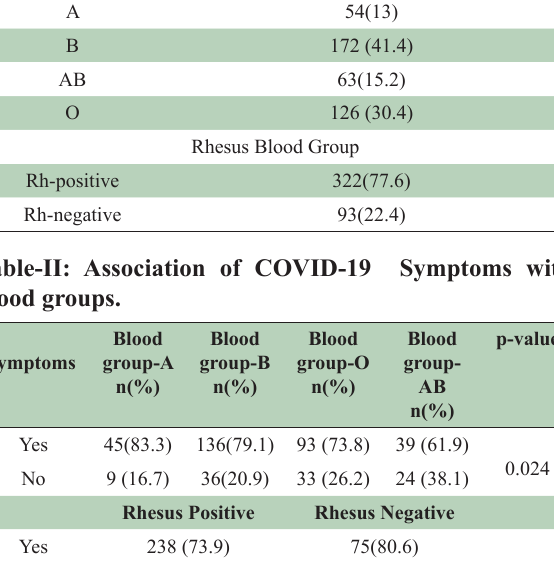
p-value≤ 0.05 taken as significant.